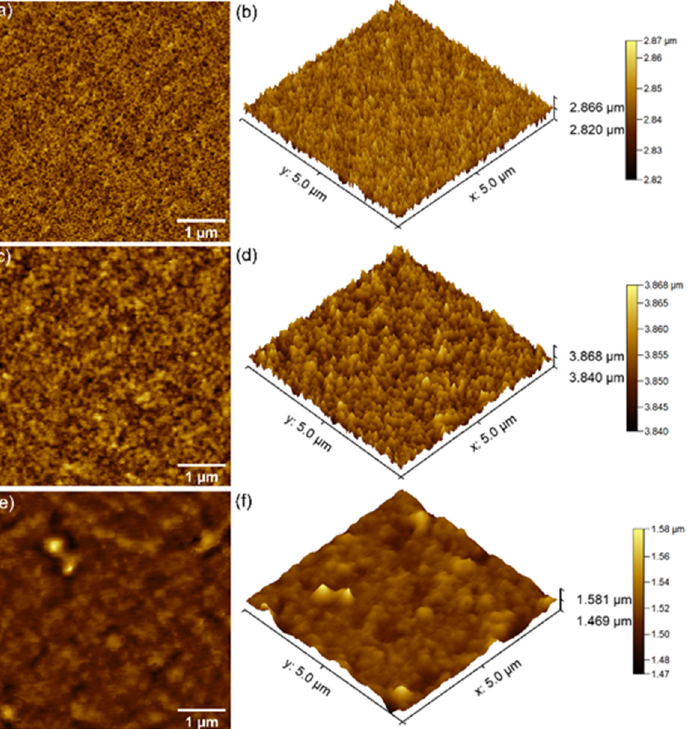
Figure 9. 2D AFM topographies of 10 MgHApCh-0 ( a ), 10 MgHApCh-3 ( c ) and 10 MgHApCh-6 ( e ) composite layers and their 3D representations ( b , d , f ).